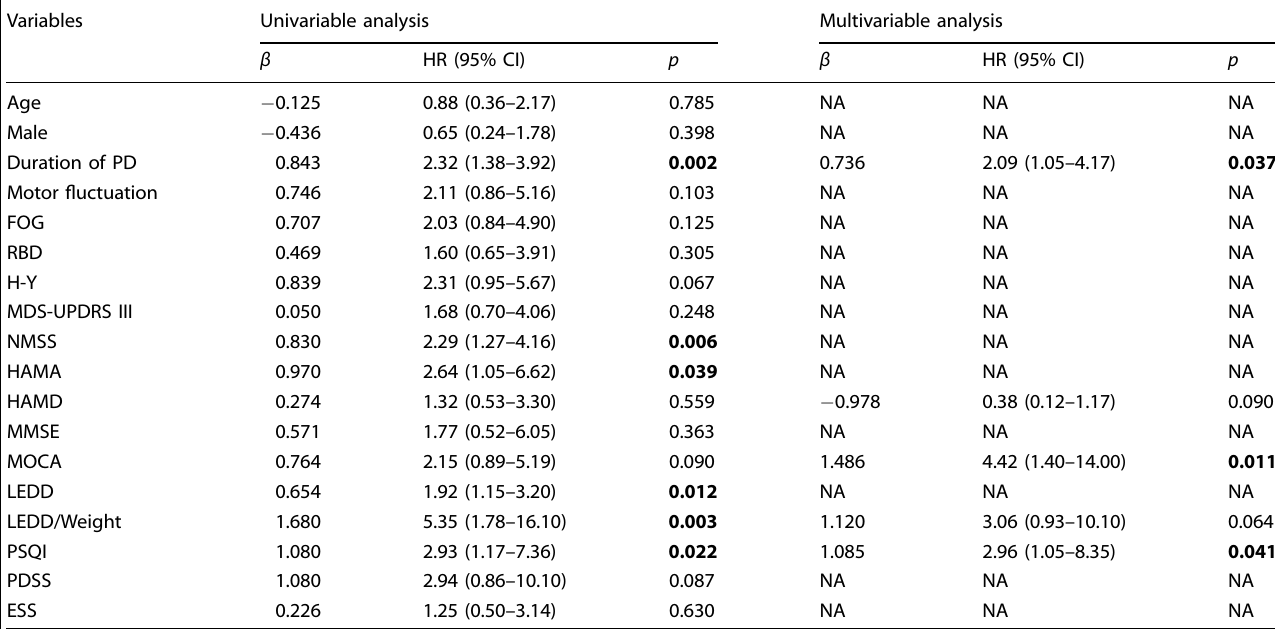
Table 2. Cox regression analyses of dyskinesia ( N =